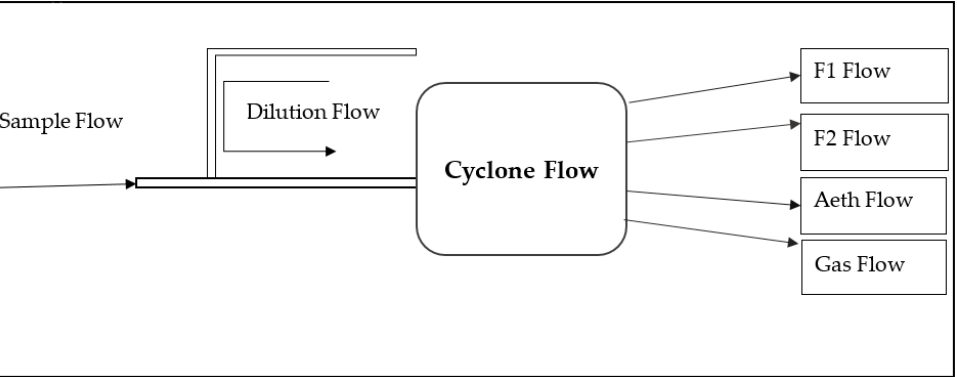
Figure 2. Flow mechanism in the Ratnoze1. The cyclone flow (sample flow mixed with dilution flow) is distributed into F1 and F2 flows to filters for gravimetric measurement, gas flow for particulate and gas sensors, and Aeth flow for measurement of black carbon.